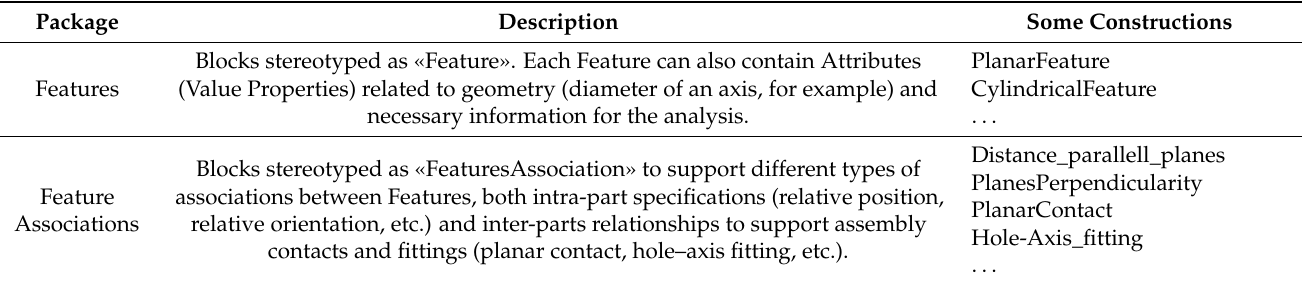
Table 1. FMLP sub ‐ packages and contents.